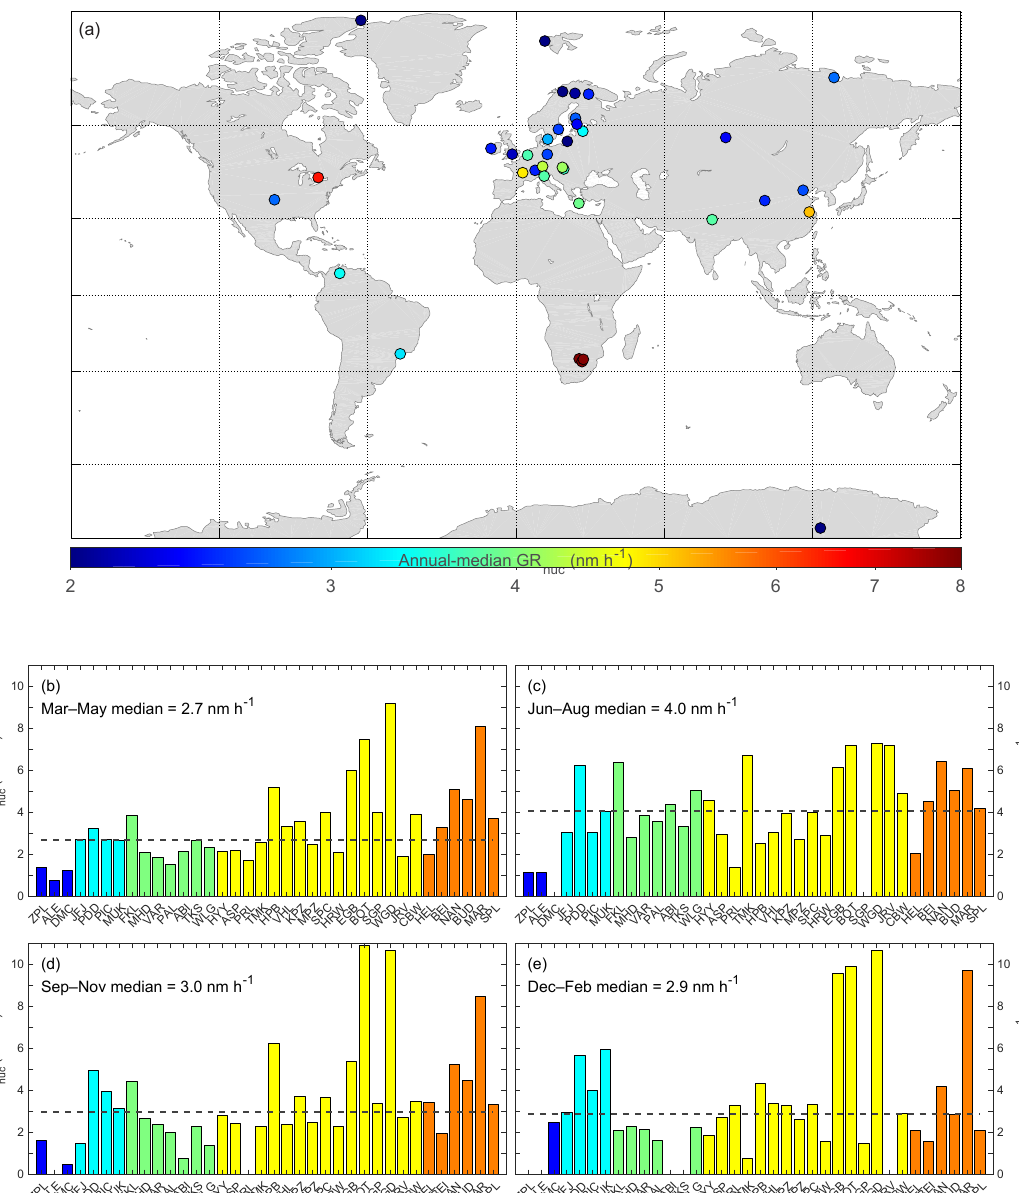
Figure 5. Annual-median (a) and seasonal-median (b–e) particle growth rates at the different measurement sites. The dashed lines in panels (b–e) show the median seasonal values, and the color scheme represents the classification of the sites into polar, high-altitude, remote, rural, and urban